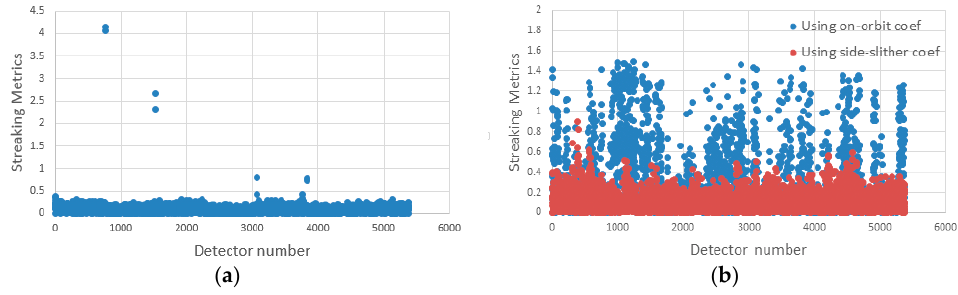
Figure 13. Streaking metrics of water images: ( a ) Streaking metrics of the raw image; ( b ) Streaking metrics of the images corrected using on-orbit coefficients and side-slither coefficients, respectively.